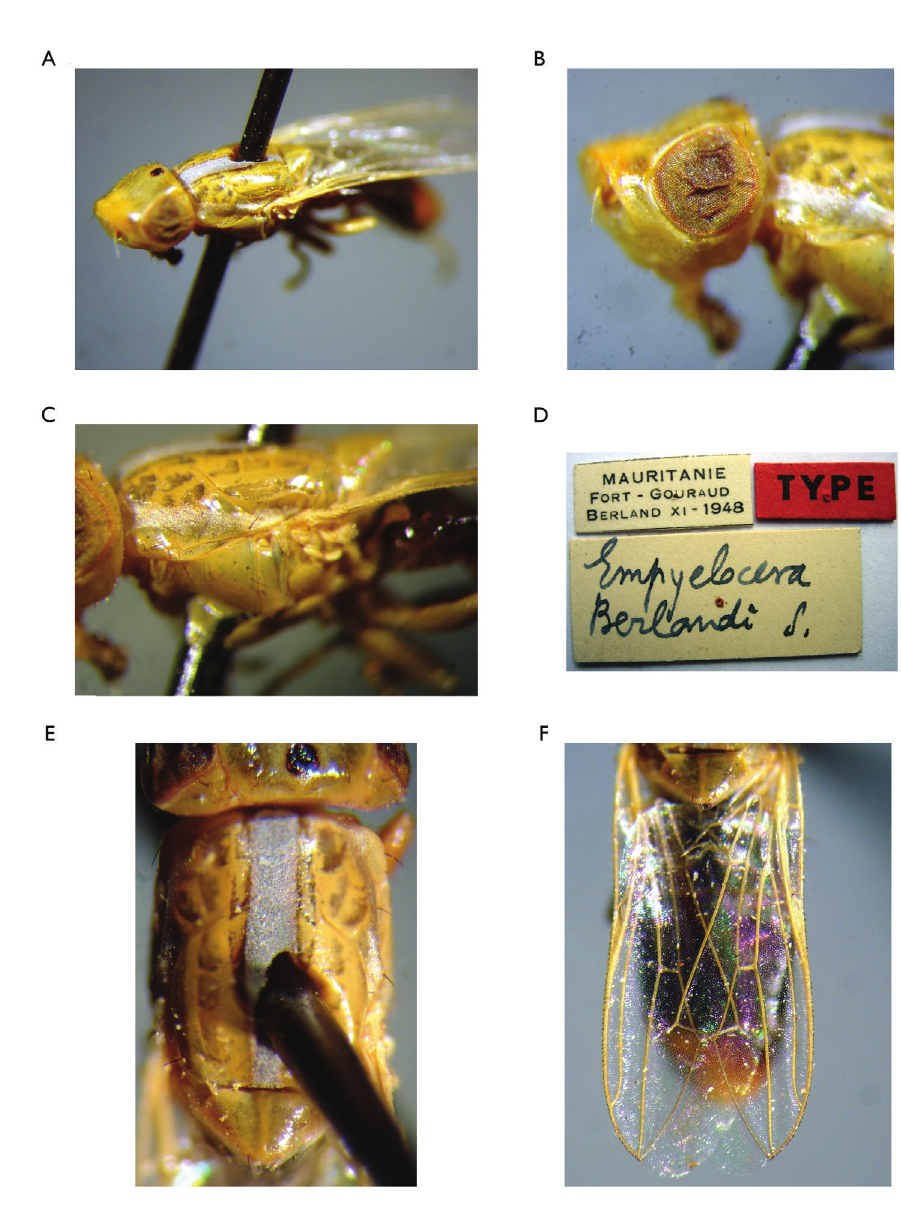
Figure 4. Timia berlandi (Seguy, 1953), holotype male A habitus, lateral view B head, lateral view C thorax, lateral view D label E thorax, dorsal view F wing (after Kameneva 2010, with